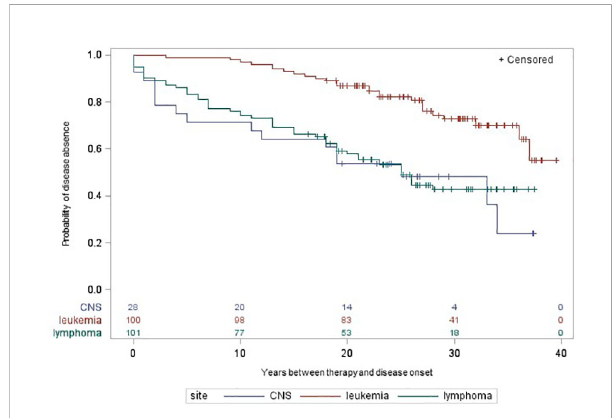
FIGURE 1 Time between self-reported radiotherapy and onset of late adverse diseases of the thyroid gland by cancer site in participants of the nested case-control study KiKme. Participants were included, if they received radiotherapy for a fi rst primary cancer diagnosis (n=277). Thyroid cancers occurring as second primary neoplasms were excluded for this analysis. CNS, central nervous system.